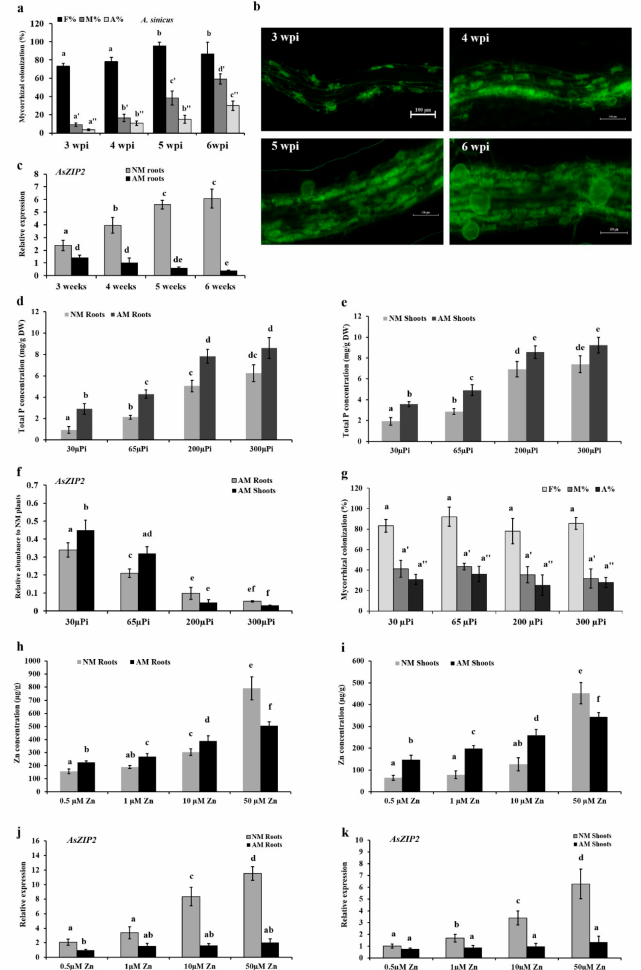
Figure 5. Arbuscular mycorrhizal colonization reduces the expression of Zn transporter gene AsZIP2 in a phosphate-dependent manner. ( a – c ) Mycorrhization strongly represses the AsZIP2 expression in A. sinicus roots inoculated with (AM) or without (NM) R. irregularis . ( a , b ) The mycorrhization in A. sinicus roots colonized by R. irregularis , grown under low Pi (30 µ M) conditions at different weeks post-inoculation (wpi). ( a ) Mycorrhizal colonization levels were determined after WGA488 staining. F%, the total colonization frequency; M%, the percentage of mycorrhizal intensity; A%, the percentage of arbuscule abundance. ( b ) Fluorescence microscope images of R. irregularis within roots at different wpi. Scale bars, 100 µ m. ( c ) The expression of AsZIP2 in NM and AM roots of A. sinicus at different weeks. NM, nonmycorrhizal; AM, arbuscular mycorrhizal. ( d – g ) The expression pattern of AsZIP2 in A. sinicus plants is dependent on the phosphate status during AM symbiosis. Total P concentrations were determined in the roots ( d ) and shoots ( e ) of NM and AM A. sinicus grown under the indicated Pi conditions shown. ( f ) The expression of AsZIP2 in AM roots and shoots of A. sinicus in response to different Pi concentrations indicated, estimated by real-time qRT-PCR. AsActin from A. sinicus served as the internal control. ( g ) The effect of different Pi availability on arbuscular mycorrhization in A. sinicus roots at 42 dpi. ( h – k ) The transcription of AsZIP2 is independent of the Zn status in A. sinicus during AM symbiosis. Zn concentrations were estimated in the roots ( h ) and shoots ( i ) of NM and AM A. sinicus during different Zn conditions indicated. Transcription of AsZIP2 in the roots ( j ) and shoots ( k ) of NM and AM A. sinicus exposed to different Zn concentrations indicated, measured by real-time qRT-PCR. Error bars represent the SD for means of three biological replicates. Different letters indicate statistically significant differences at p < 0.05, based on the Duncan’s multiple range